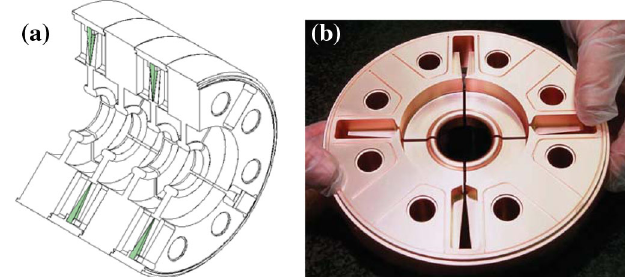
FIG. 4. (Color) Cross-sectional view of the slotted iris-constant aperture (SICA) geometry used for DBA wakefield damping (left) [46] and a prototype single cell (right) [47].